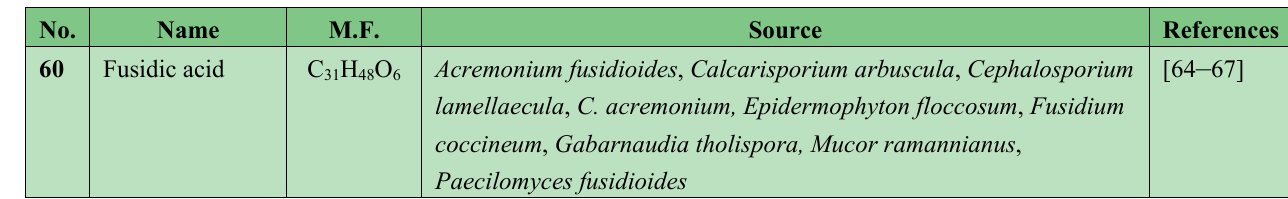
Table 2. Naturally occurring fusidane